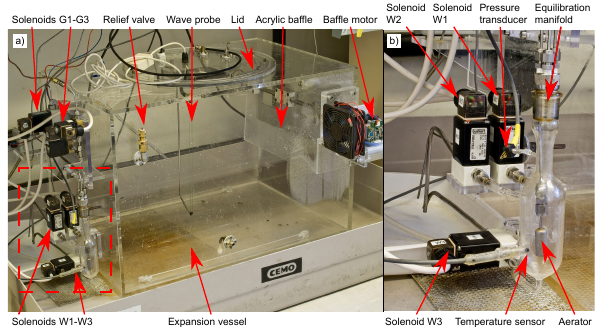
Figure 2. Annotated photograph of the gas exchange apparatus: (a) the gas exchange tank. Note that the overflow vessel usually connected to the expansion vessel is omitted for clarity; (b) the equi- libration vessel shown by the dashed red box in image (a)